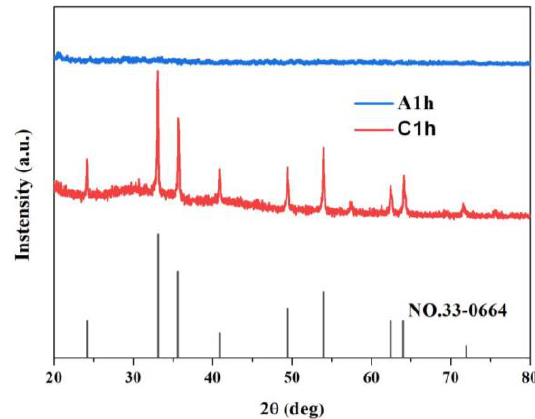
Figure 2. XRD patterns of the samples A1h and C1h.